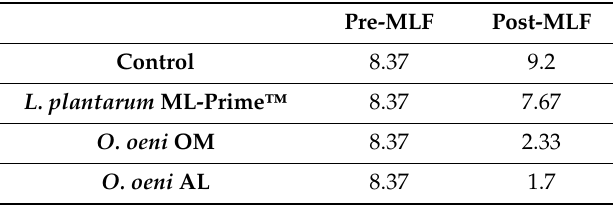
Table 3. Acetaldehyde concentration (mg / L) in a Pinot noir wine pre- and post-MLF and a control wine without MLF extracted from Bartowsky and Krieger-Weber